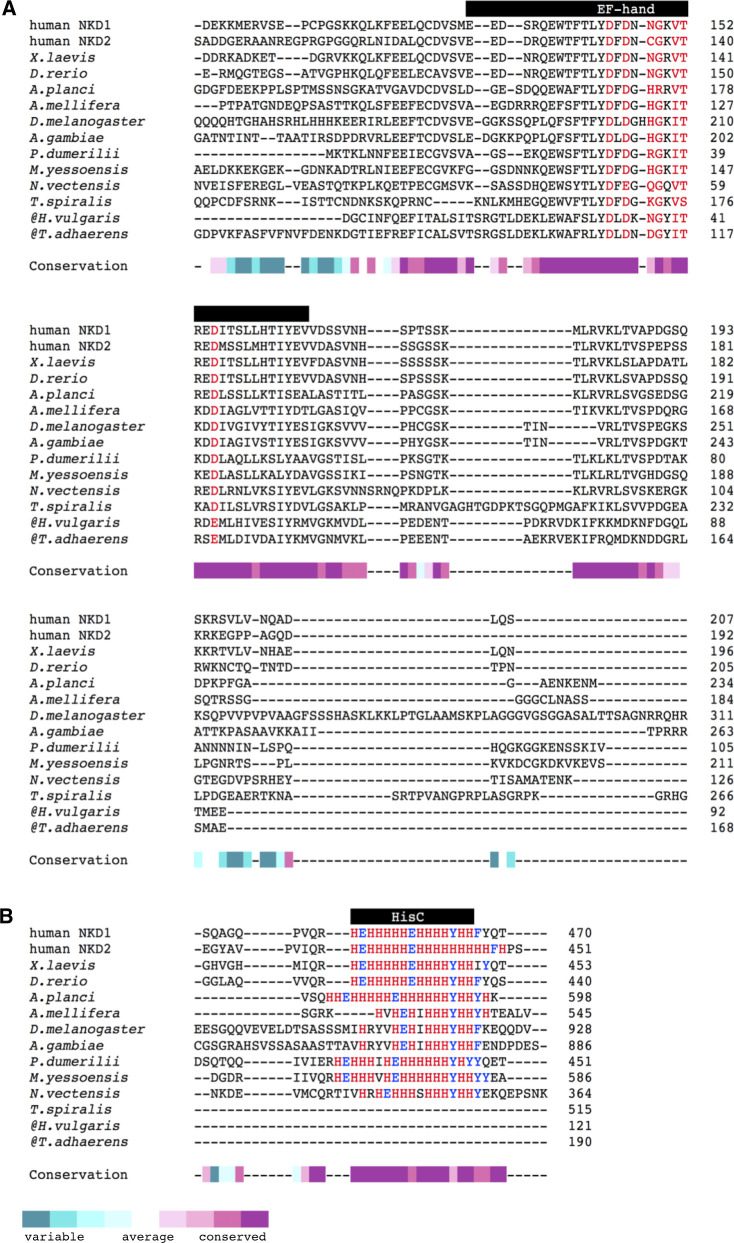
Sequence conservation of Naked/NKD orthologs.Sequence alignments of the (A) EF-hand and the (B) C-terminal HisC cluster across diverse animal species. @, C-terminal sequences not available. Conservation score was calculated with the ConSurf webserver.